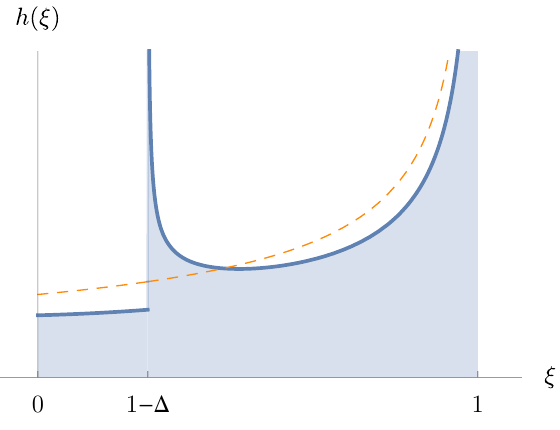
Figure 3 . The auxiliary function h ( (cid:24) ) calculated numerically for n = 4, (cid:1) = 3 = 4. The strong- p coupling ( n ! 1 ) asymptotics h 1 ( (cid:24) ) = 2 = 1 (cid:0) (cid:24) is displayed as a dashed line for